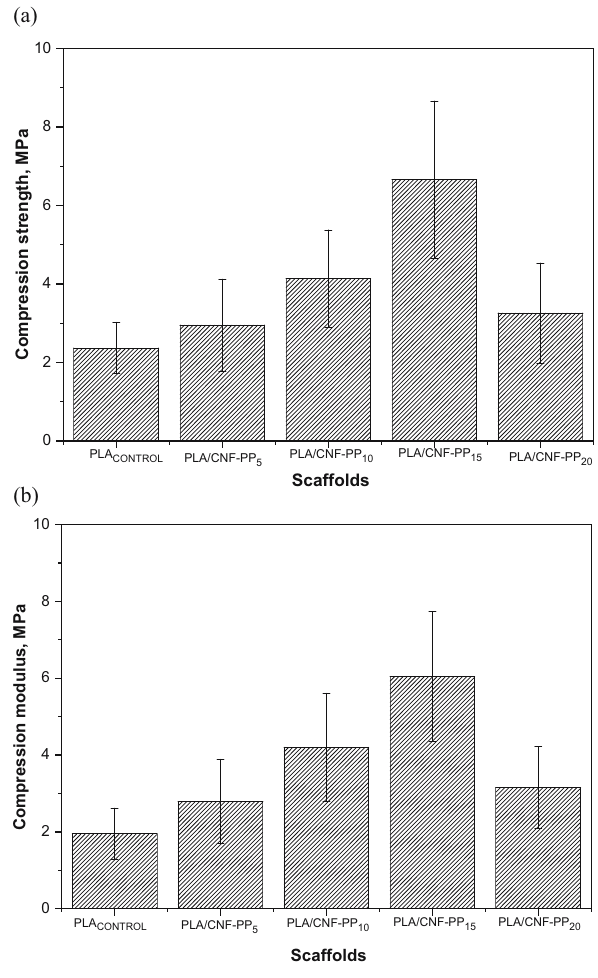
Figure 7: ( a ) Compression strength and ( b ) compression modulus of PLA sca ff olds with di ff erent CNF